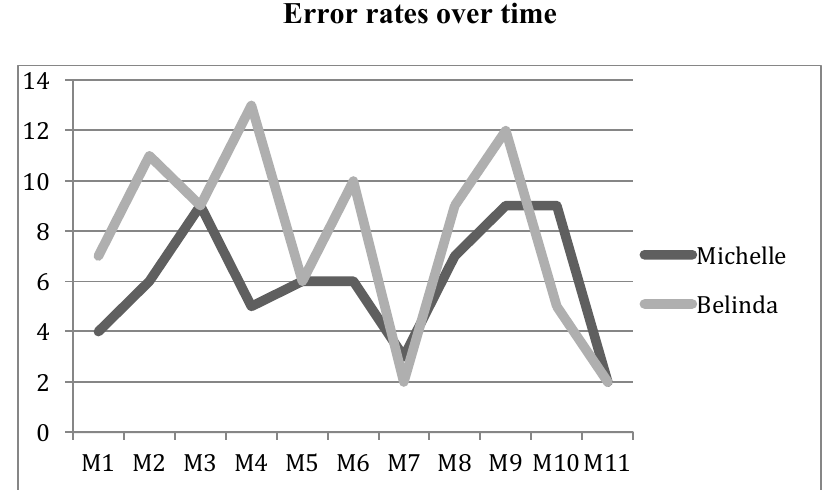
FIGURE 1 Error rates over